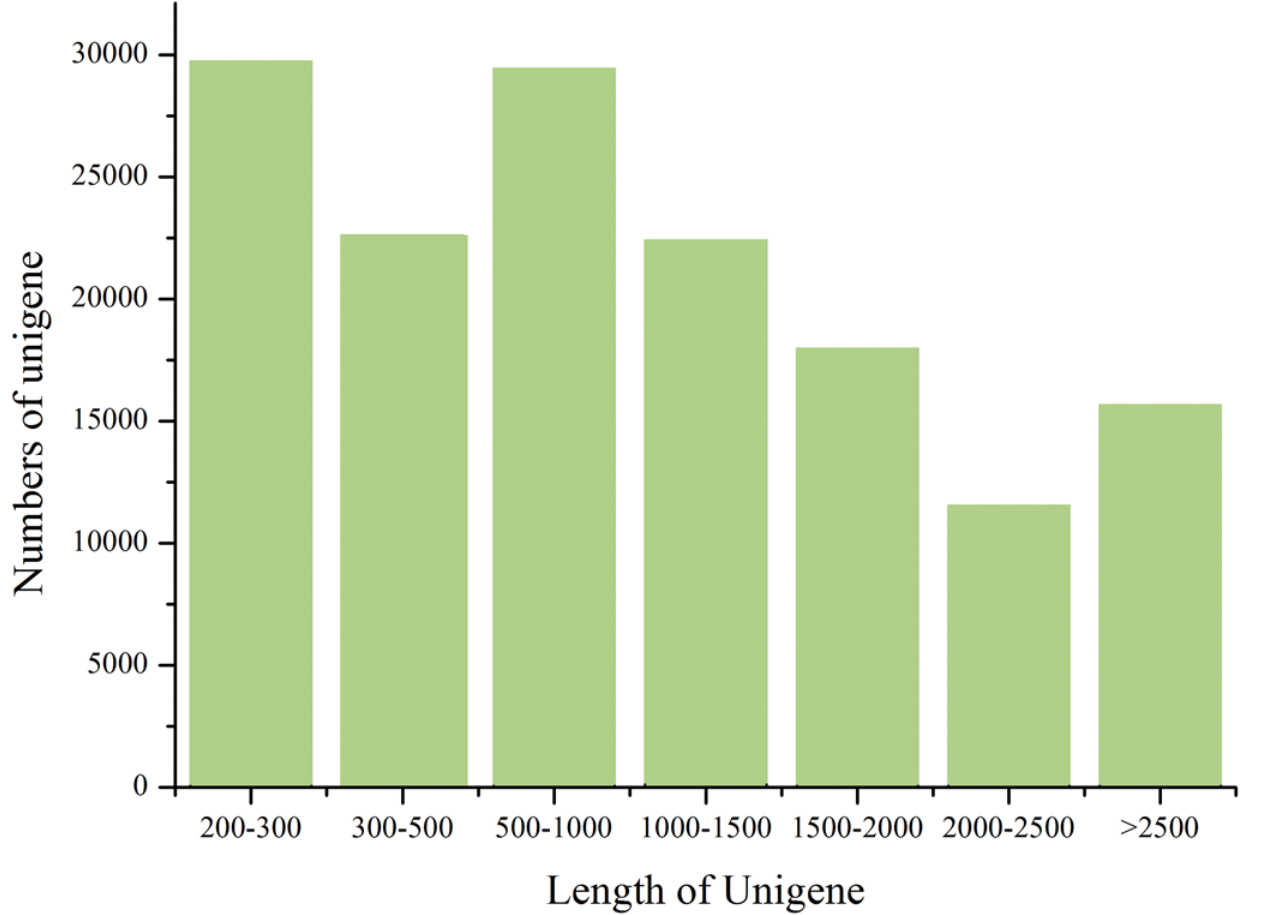
Fig 2. The distribution of the unigenes ’ lengths. The horizontal and vertical axes show the size and the number of unigenes